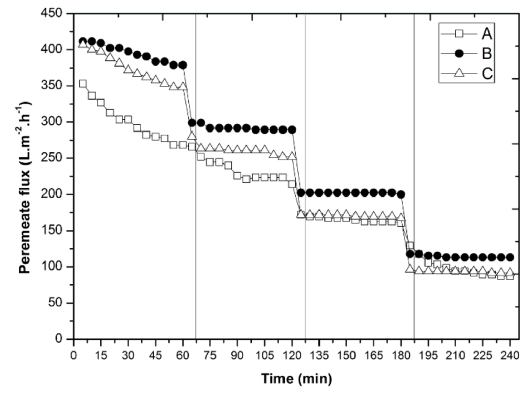
Figure 7. Permeate flux to the mullite tubular membrane tested at different pressures. Where A is distilled water containing Escherichia coli , B the initial test with distilled water and C the test with distilled water after the test A after membrane cleaning with sodium hypochlorite 3% (v/v).